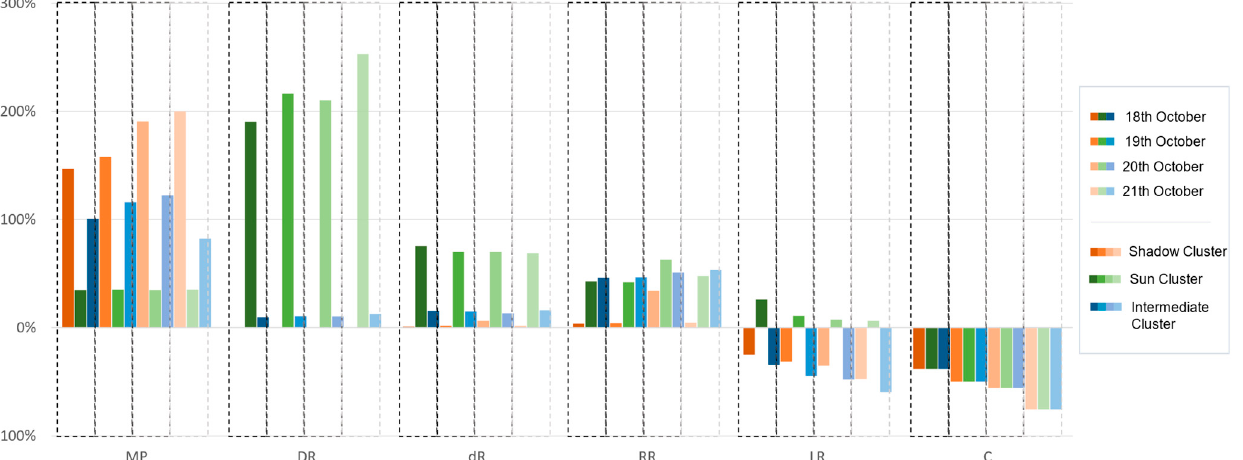
Figure 19. Influence of the factors affecting human comfort on the objective thermal sensation cal-